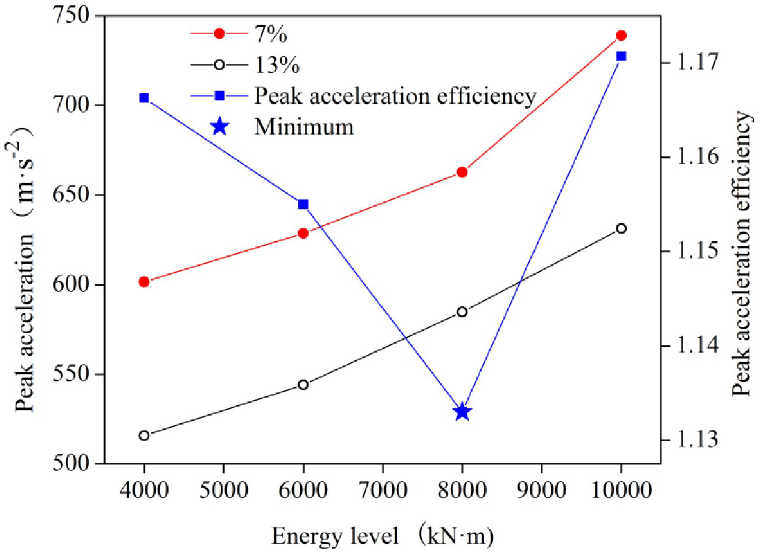
Fig 8. Curves of the final peak acceleration and E a verses the energy level.